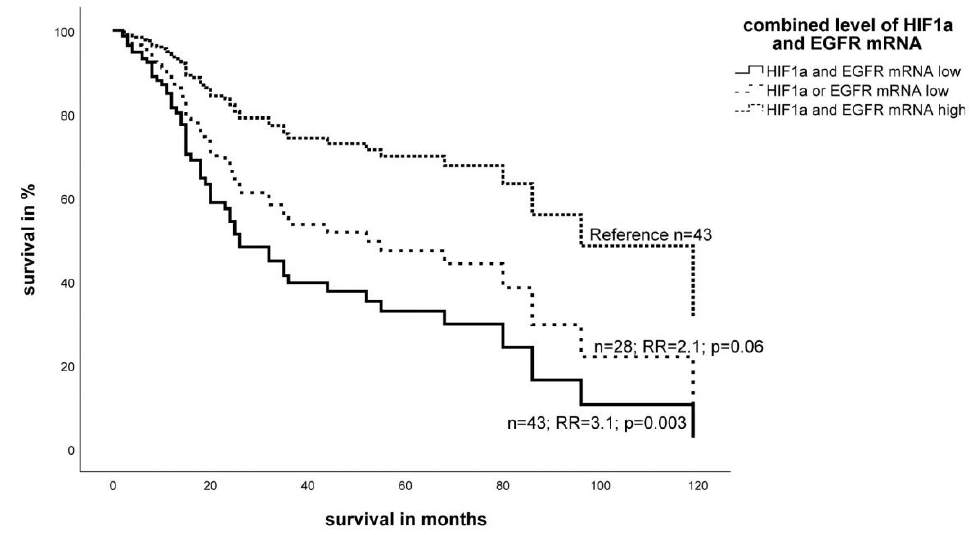
Figure 3. Multivariate Cox’s hazard regression model for the combination of HIF-1 α and EGFR mRNA expression and tumor-specific survival in STS patients. The expression of HIF-1 α mRNA and EGFR mRNA for 114 STS patients was associated with survival. The model was adjusted for tumor stage, tumor localization, tumor entity, and the type of tumor resection. If both markers had a low expression in the tumor, the prognosis of the patients was worse (RR = 3.1, p = 0.003) compared to high expression of both markers in the